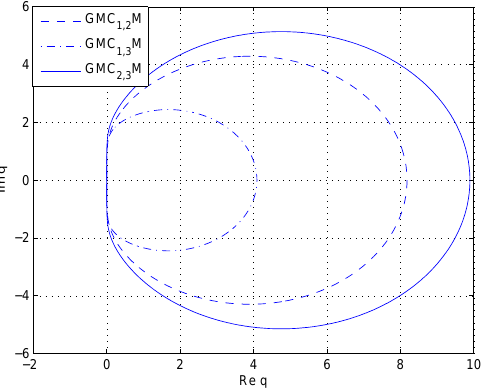
Figure 2. Linear stability region for GMC 1,2 M , GMC 1,3 M , GMC 2,3 M .